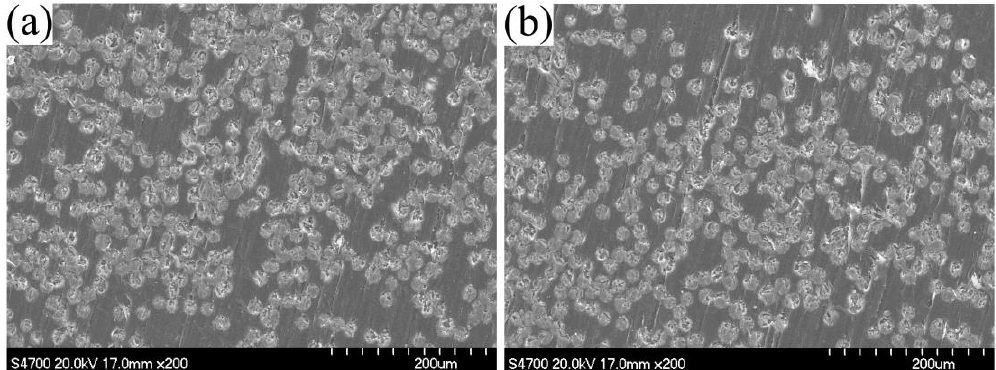
Figure 7. SEM micrographs of the polished composites with injection chamber at 90 °C ( a ) and 100 °C ( b ).